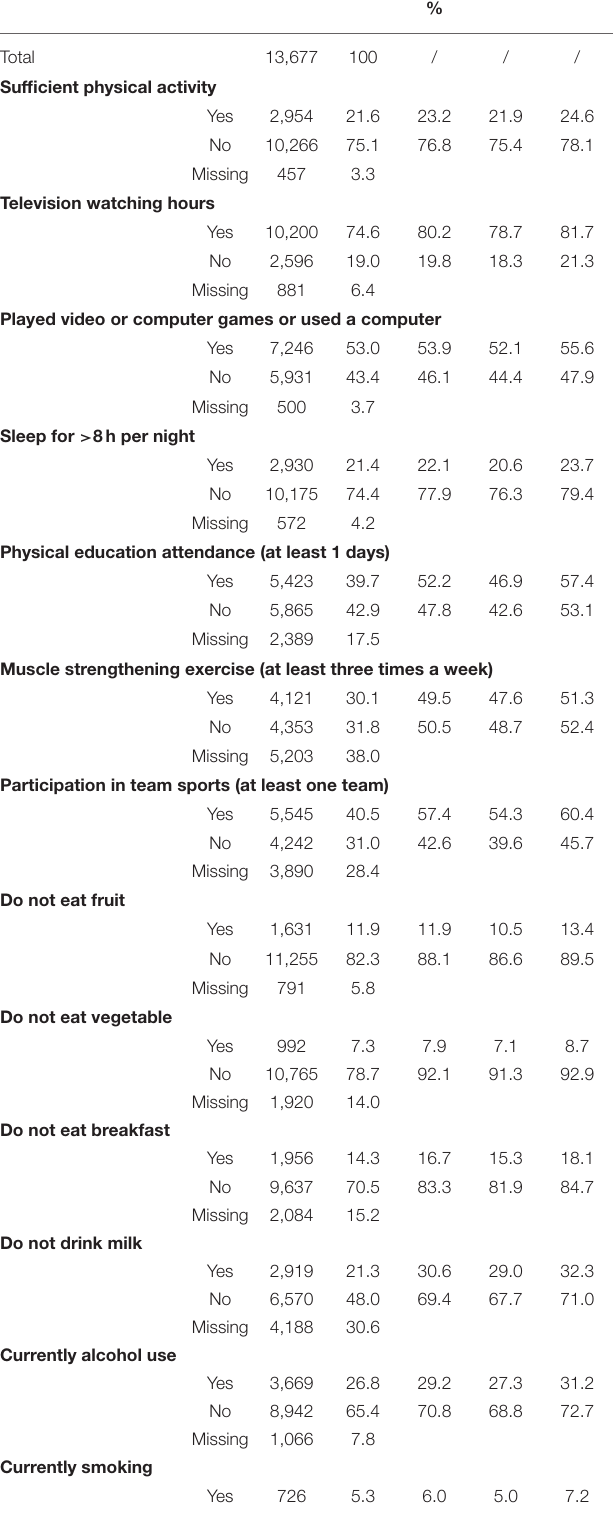
TABLE 2 | Prevalence of lifestyle behaviors and suicide-related behaviors. N % Weighted %